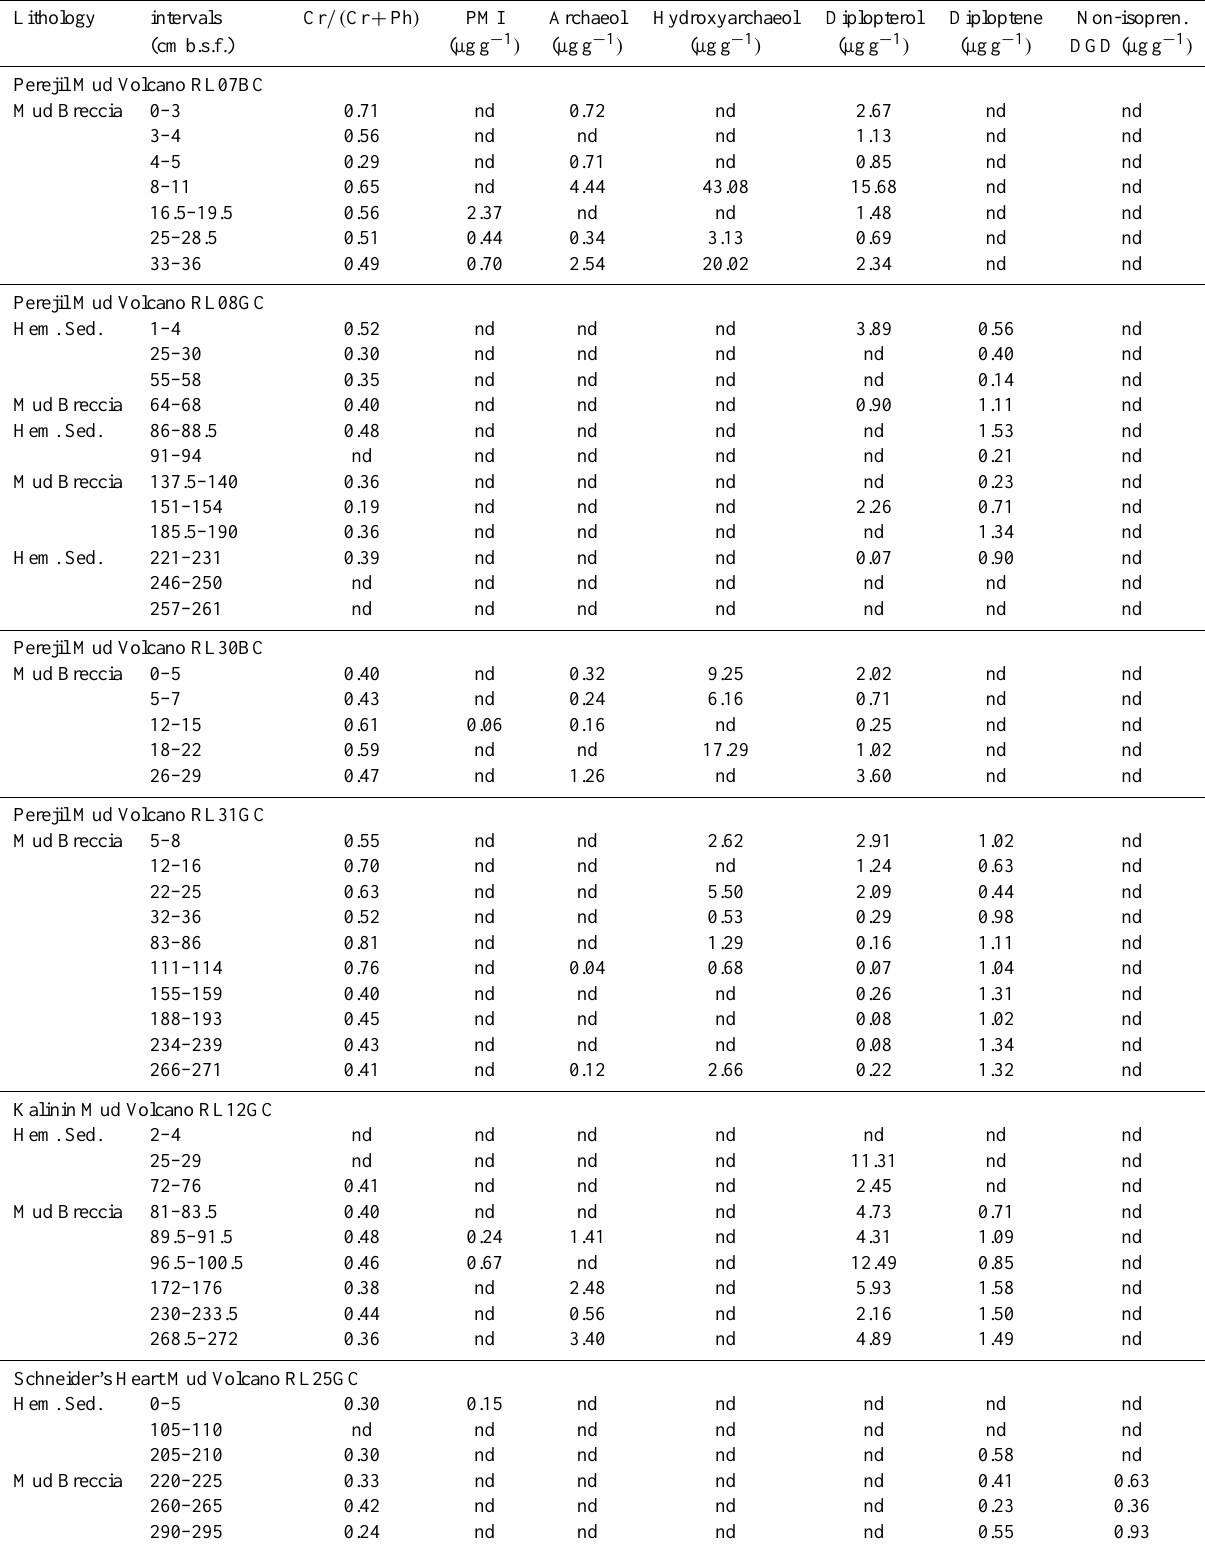
Table 4. Depth distributions of concentration of acyclic archaeal isoprenoids diagnostic for methanotrophic archaea and specific methanogen biomarkers such as diploptene and diplopterol for Perejil crater and flank, Kalinin, and Schneider’s Heart MVs. Lithology intervals Cr /( Cr + Ph ) PMI Archaeol Hydroxyarchaeol Diplopterol Diploptene Non-isopren. (cmb.s.f.) (µgg − 1 ) (µgg − 1 ) (µgg − 1 ) (µgg − 1 ) (µgg − 1 ) DGD (µgg − 1 ) Perejil Mud Volcano RL07BC Mud Breccia 0–3